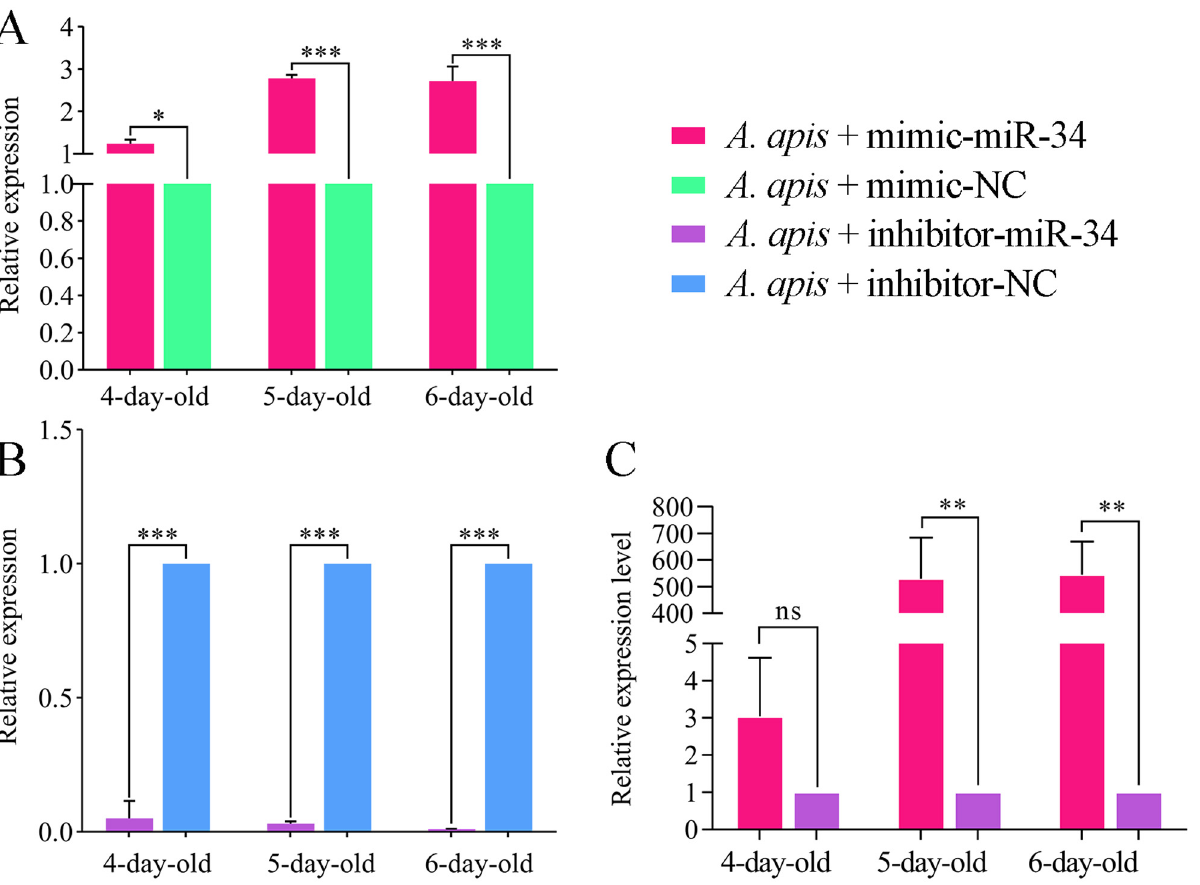
Figure 4. Detection of relative expression level of ame-miR-34 in A. apis -infected A. mellifera larval guts. ( A ) Relative expression level of ame-miR-34 in the A. apis -infected larval guts after feeding mimic-miR-34; ( B ) relative expression level of ame-miR-34 in the A. apis -infected larval guts after feeding inhibitor-miR-34; ( C ) relative expression level of ame-miR-34 in the larval guts after feeding mimic-miR-34 in comparison with that after feeding inhibitor-miR-34. Data were presented as mean SD and subjected to Student’s t -test, ns: p > 0.05, *: p < 0.05, **: p < 0.01, ***: p < 0.001.